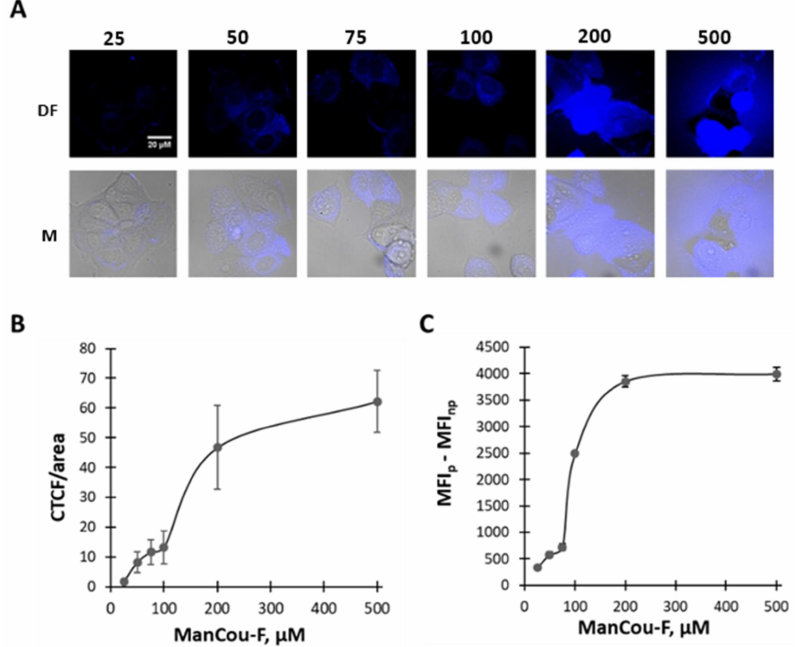
Figure 3. Uptake analysis of different concentrations of ManCou-F ( A ) by confocal microscopy ( B ) and flow cytometry ( C ). ( A ) Representative confocal fluorescent images of concentration- dependent uptake of the probe by MCF7 cells. Images were acquired using a 60 × objective and DAPI filter (exc/em: 405 nm/461 nm) at the same laser intensity and exposure time, DF—dark field, and M—fluorescence overlay images with the bright field. Each experiment was carried out in duplicate. ( B ) CTCF quantitated fluorescence. Quantitative fluorescence data were derived from fluorescence images of probe-treated cells using ImageJ as (CTCF = (IntDens (cell)) − (Int Den (bgr)) × Area (cell)). For confocal analysis, data were derived for two images per sample (~5–10 cells/image). Error bars represent the standard deviation of cell fluorescence. ( C ) Fluorescence obtained by Attune NxT Flow Cytometer using VL1 filter was processed as MFI probe (median of fluorescence intensity)-MFI np (MFI of the cells with no treatment). MFI was derived excluding debris and doublets by FSC-SSC and FSC-H-FSC-W gating, respectively. For flow analysis, data were derived for 10,000 events. Each experiment was carried out in duplicate. Error bars represent the standard deviation between two experiments. The scale bar for all images is 20 µ